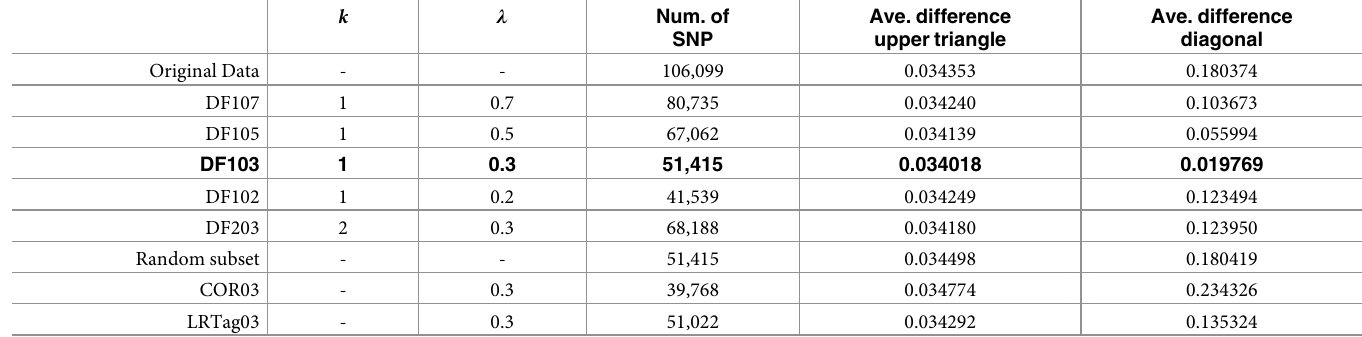
Table 1. The average difference of the upper triangle and the diagonal between pedigree-based relatedness ( A- matrix) and genomic estimated relatedness ( G- matrix). The best selected-subset for pedigree reconstruction (subset DF103) is highlighted. λ is linkage disequilibrium